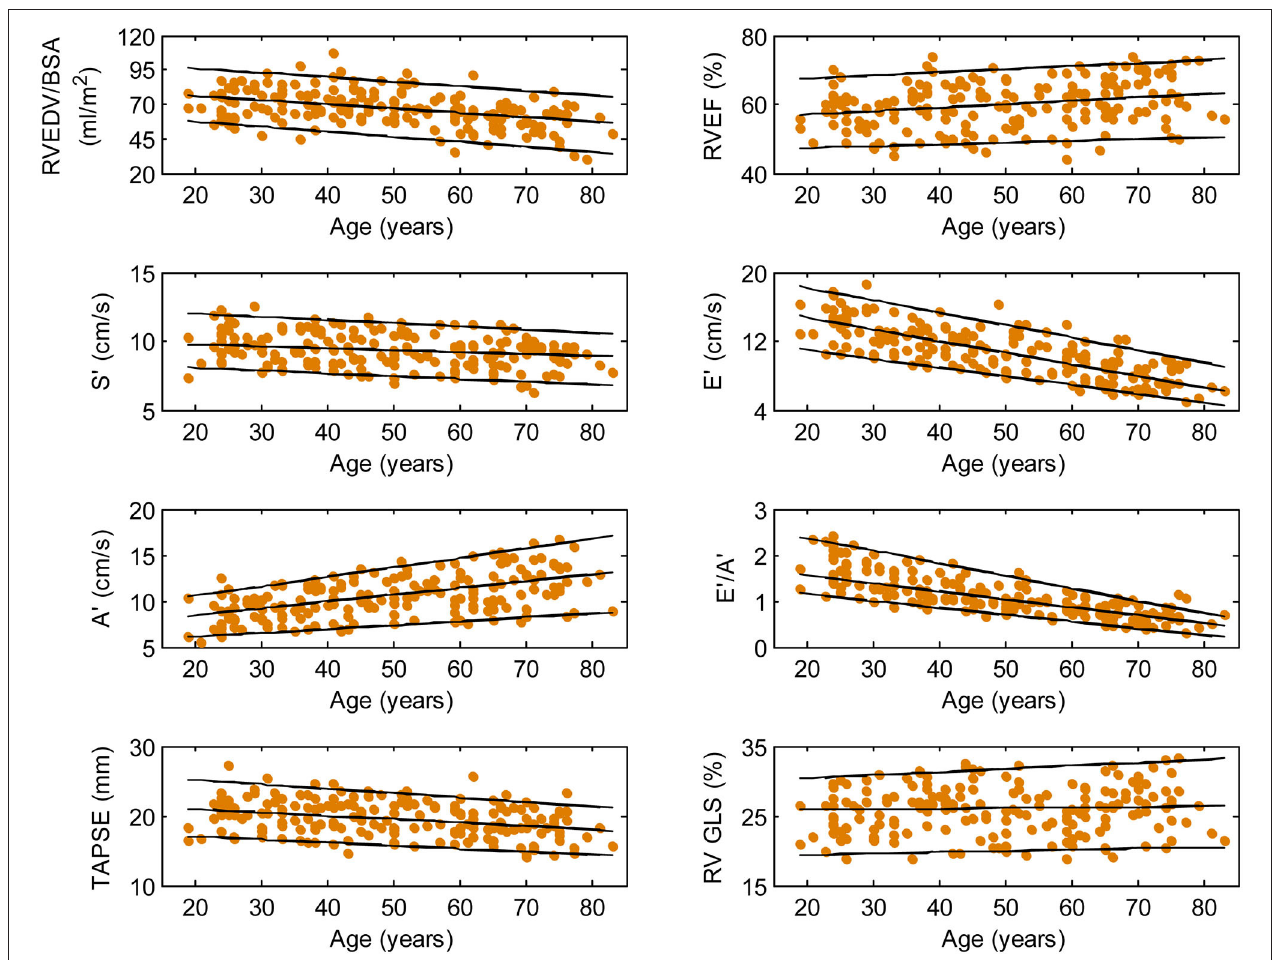
FIGURE 3 | Right ventricular parameters plotted against age in female subjects. (Central line) The 50th percentile; (Top line) The 95th percentile; (Bottom line) The 5th percentile.